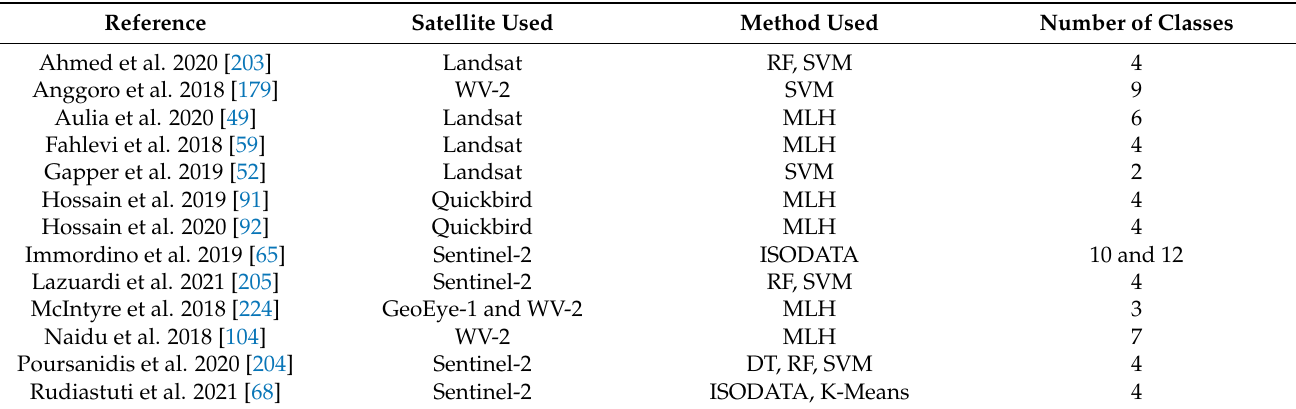
Table A1. Studies from 2018 to 2020 used to compare the accuracies of different